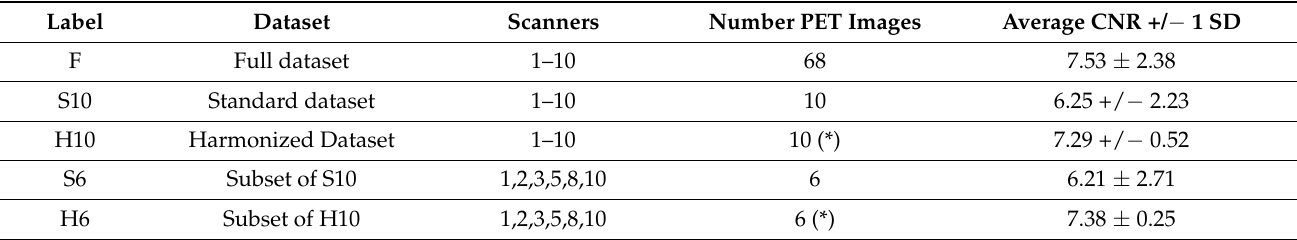
Table 4. Summary of datasets for the reproducibility